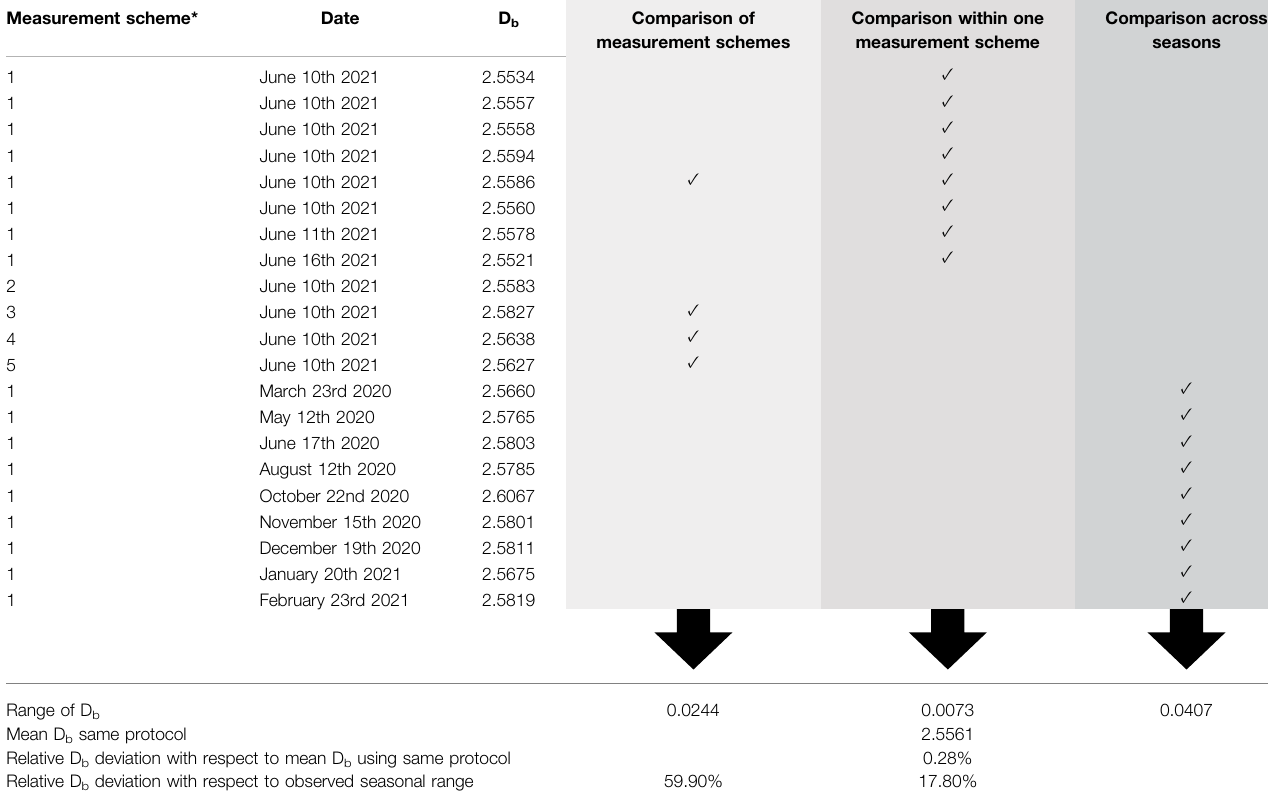
TABLE 3 | Range in D b observed among the scans made on the same site with varying measurement schemes (*see Figure 2, Chapter 2.2.1; light grey column) within a single day, 24 h later and after a week (intermediate grey column) and across the seasons (dark grey column). Check marks ( ✓ ) indicates that the respective scan in this line was used.